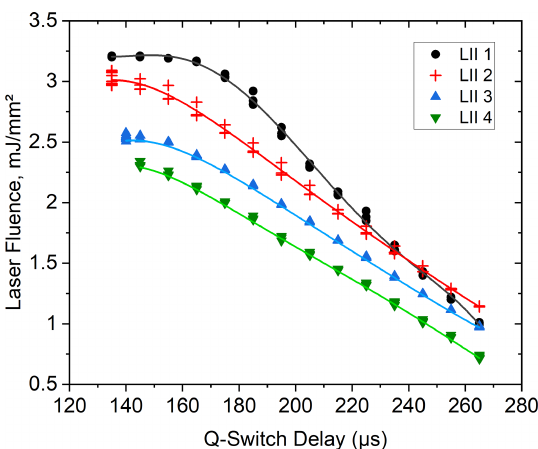
Figure 7. Correlation between the Q -switch delay settings and the laser fluence levels from the LII 300 instruments (LIIs 1–4).